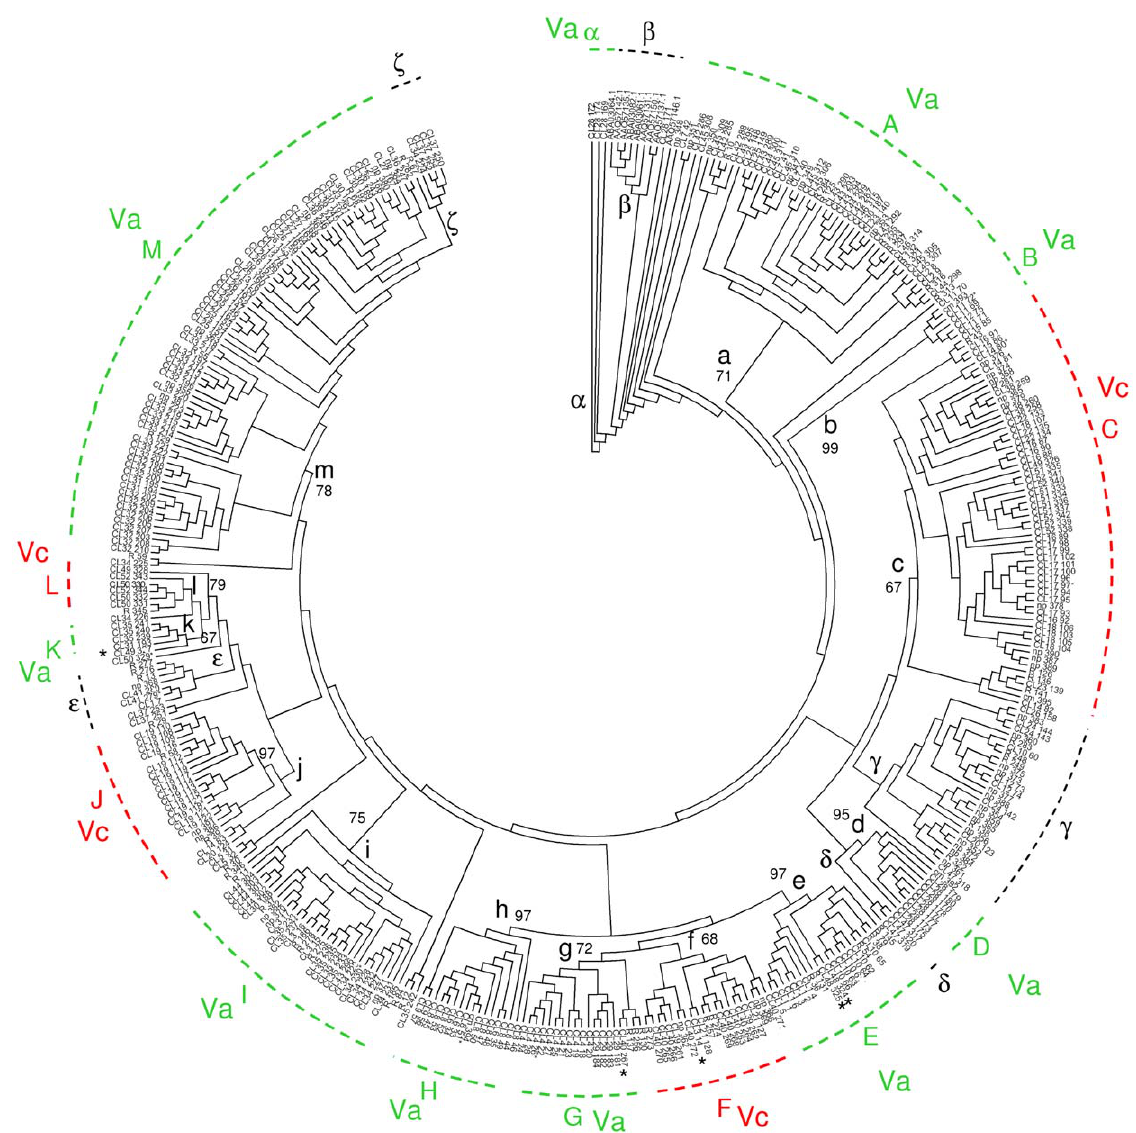
Figure 2. Phylogenetic analysis of grapevine NBS - R genes. The most abundant NBS - R gene classes were distributed among the different clades as follows: clades B, C, D, I and J included 80, 84, 88, 55, and 73% of CC- type genes, respectively; clade A included 70% of TIR- type genes; clades E, K, and M included 55, 60, and 59% of NBS-LRR genes, respectively; clades F, G, and H included 90, 63, and 67% of NBS-tr genes, respectively. Clades were assigned to Va (green) and Vc (red) genomes based only on clustered genes (Table 1 and Table S5). Asterisks mark clustered genes considered as exceptions to the genome assignment of a specific clade. Bootstrap values for clades A to M are expressed as percentages. The analysis included seven outgroup NBS - R genes of Pinus monticola